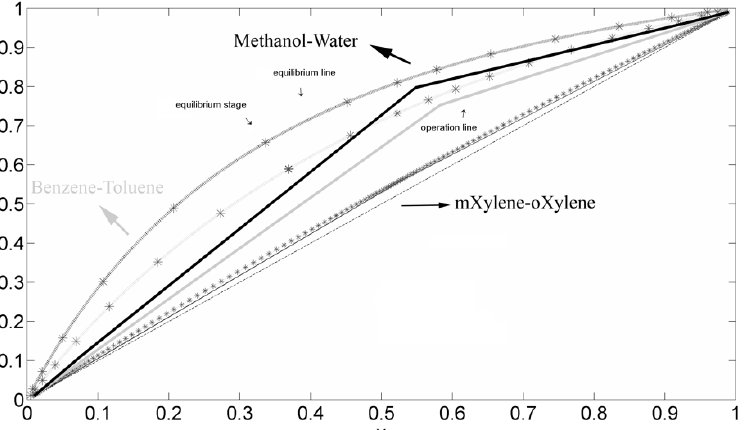
Figure 3. Vapor-Liquid equilibrium diagram of solved graphical model for conditions of Table